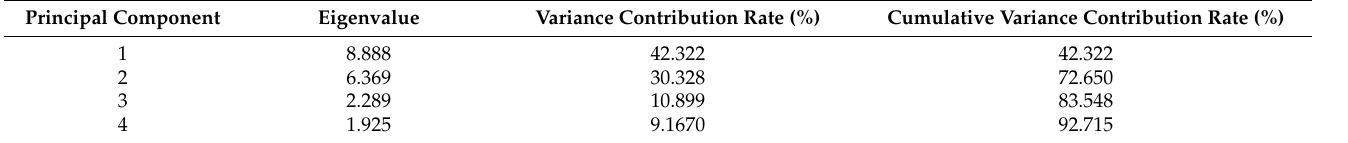
Table 3. Eigenvalue, variance contribution rate, and cumulative variance contribution